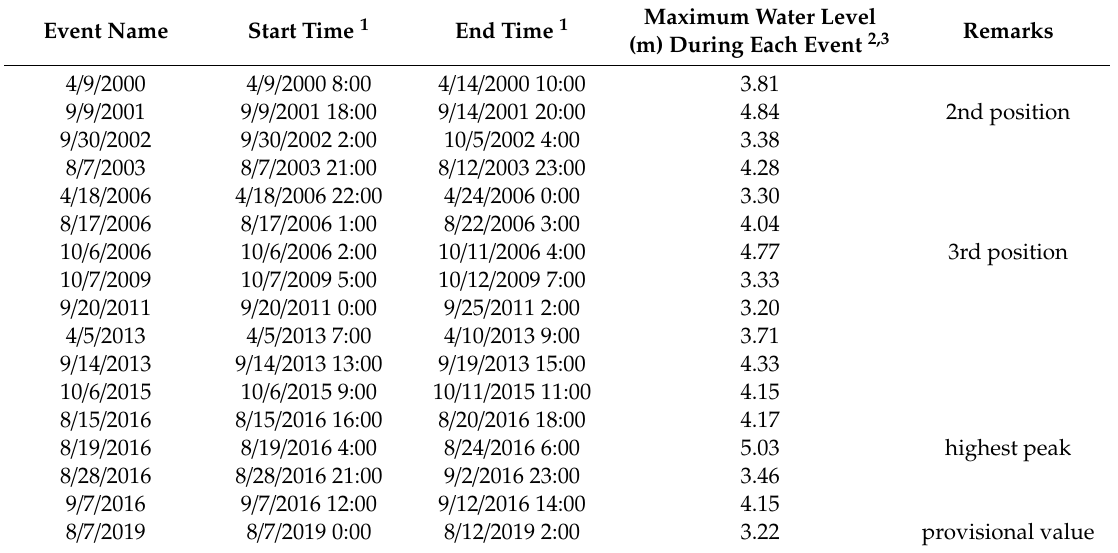
Table 2. Flood events in Domain B.